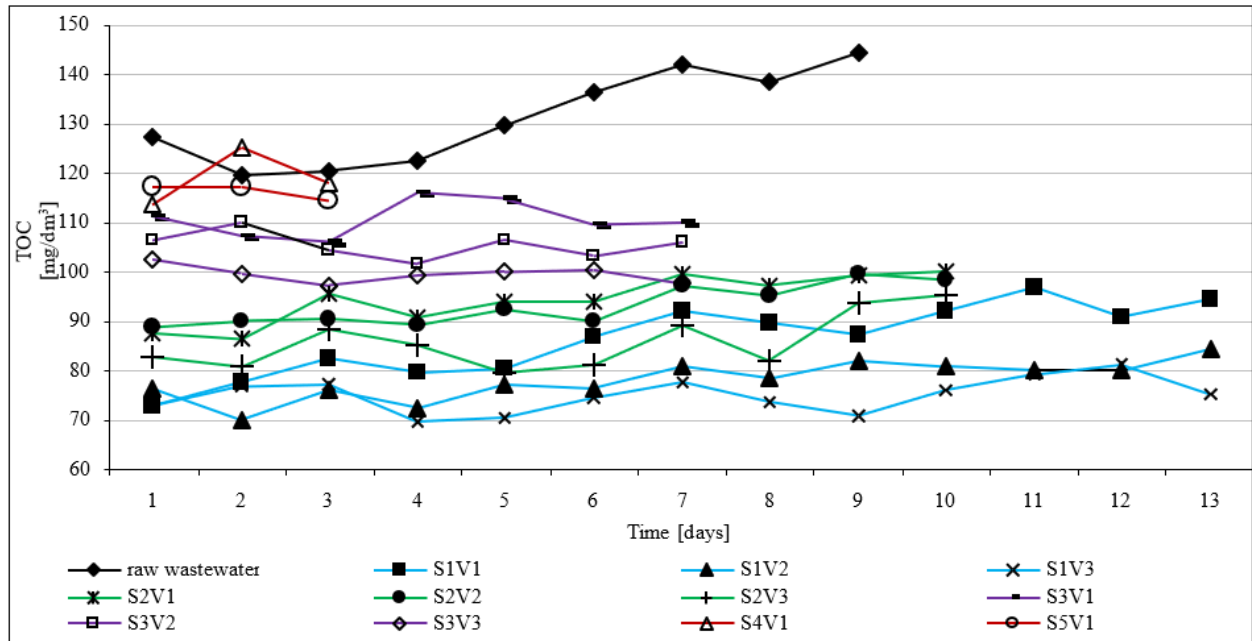
Figure 4. Changes in TOC across variants.